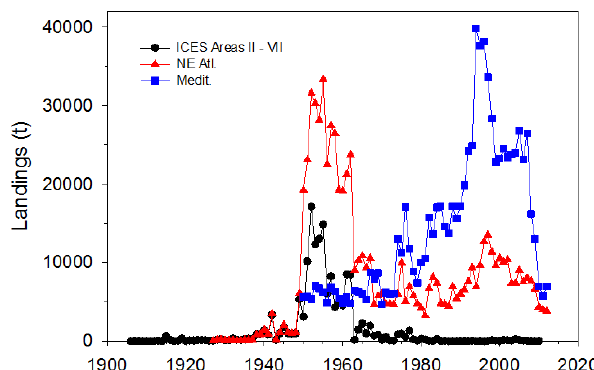
Figure 10. Temporal variability in reported catches of bluefin tuna, Thunnus thynnus , in different geographic areas. ICES areas II– VII correspond approximately to the Norwegian Sea south to the Celtic Sea and continental shelf west of Ireland and the UK (see Fig. 3). NE Atlantic includes the entire northeastern Atlantic and the Mediterranean Sea. Data sources include ICES catch databases (versions downloaded 21 January 2014) and other historical sources – see PANGAEA link for details.